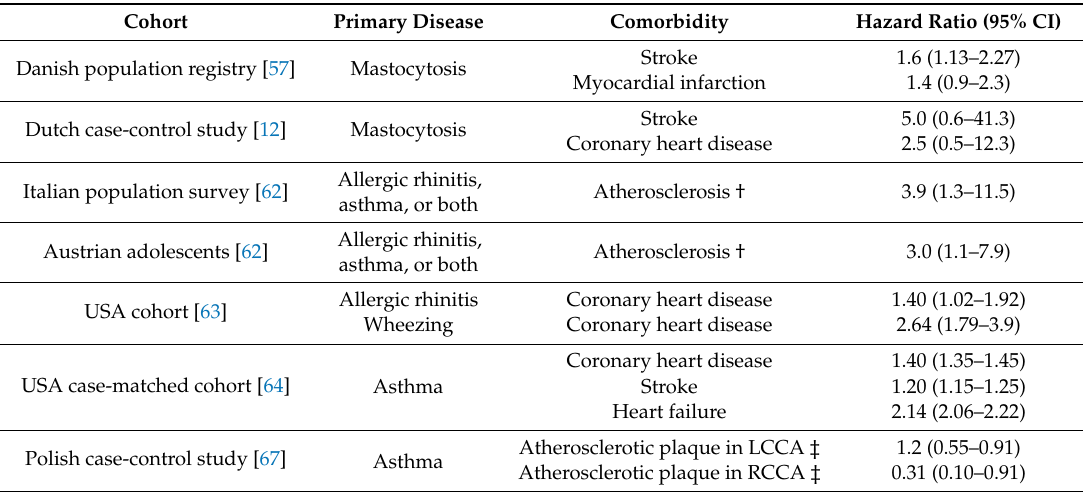
Clinical data on the risk of cardiovascular disease associated with mastocytosis or allergic